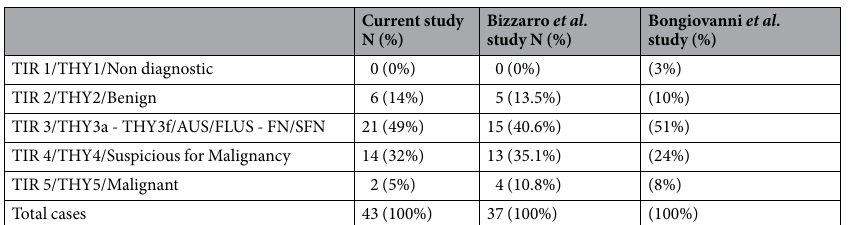
Current study N (%)